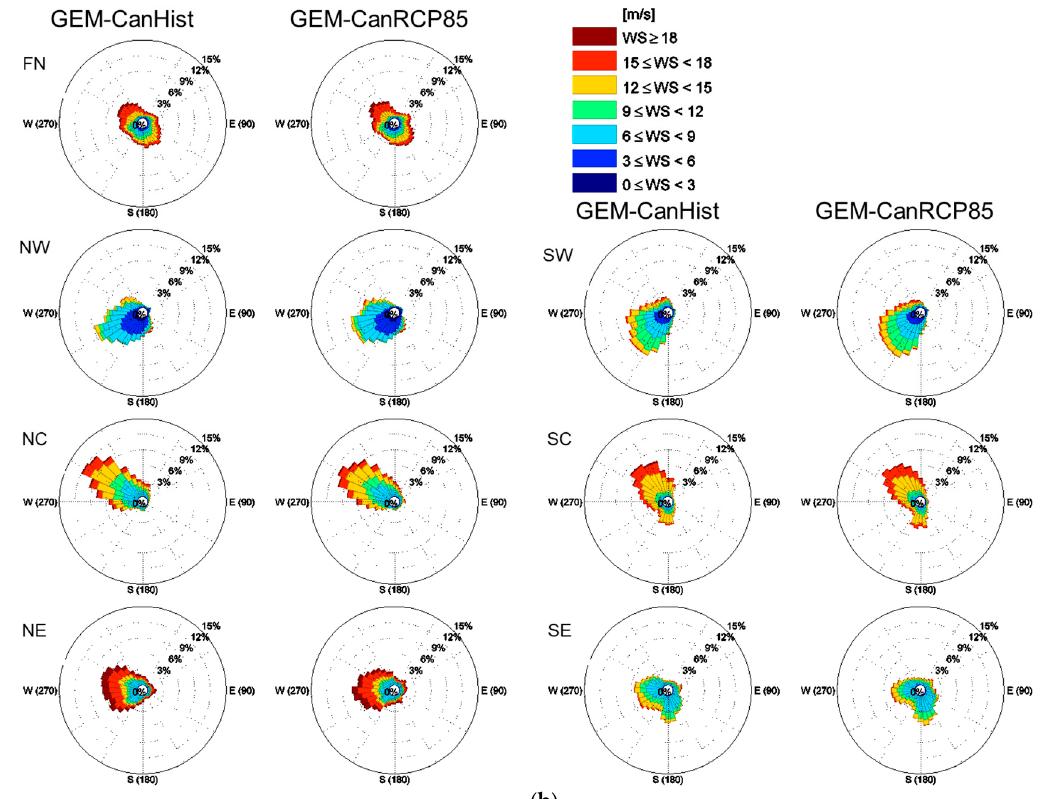
Figure 9. Directional distributions of ( a ) winter mean and ( b ) annual maximum wind speeds (3-hourly) for seven sub-regions of NA (shown in Figure 5a) for the GEM-CanHist current 1981–2010 simulation (left column) and GEM-CanRCP8.5 future 2071–2100 simulation (right column). Radial axes represent the relative frequency (in each 15° sector), and color bins indicate wind speeds shown in the legend.